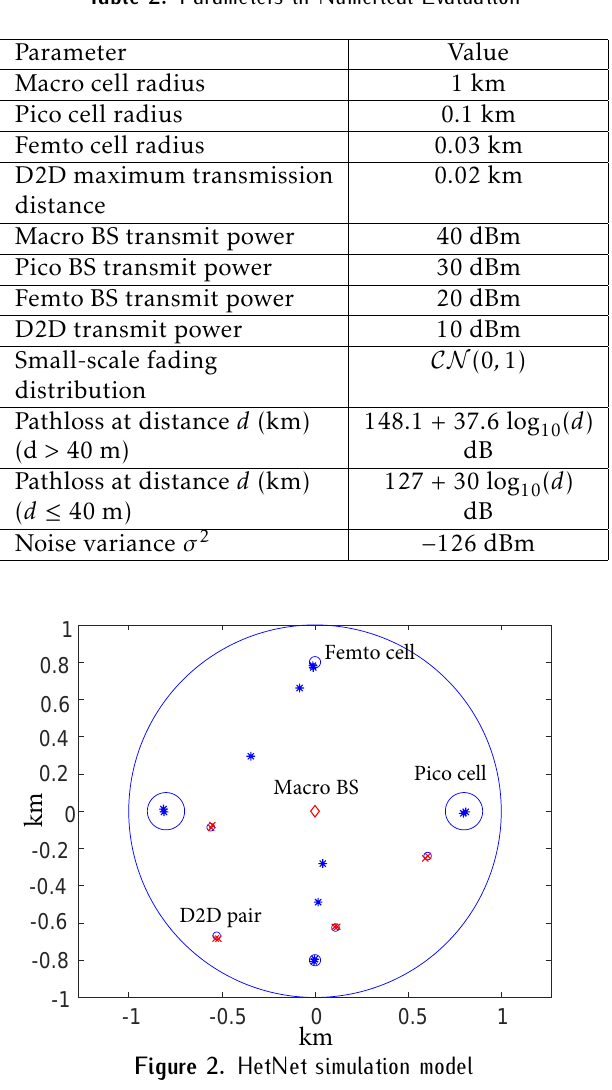
Table 2. Parameters in Numerical Evaluation